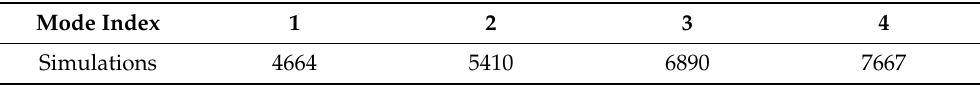
Figure 12. Instantaneous acoustic-pressure distribution, i.e., acoustic mode shape, inside a single compartment from the compartmented cavity configuration for the first two natural frequencies ( a ) f s 1 = 4664 Hz and ( b ) f s 2 = 5410 Hz. Table 2. The natural frequencies (in Hz) corresponding to the acoustic mode shape of the single-cavity unit within the compartmented cavity